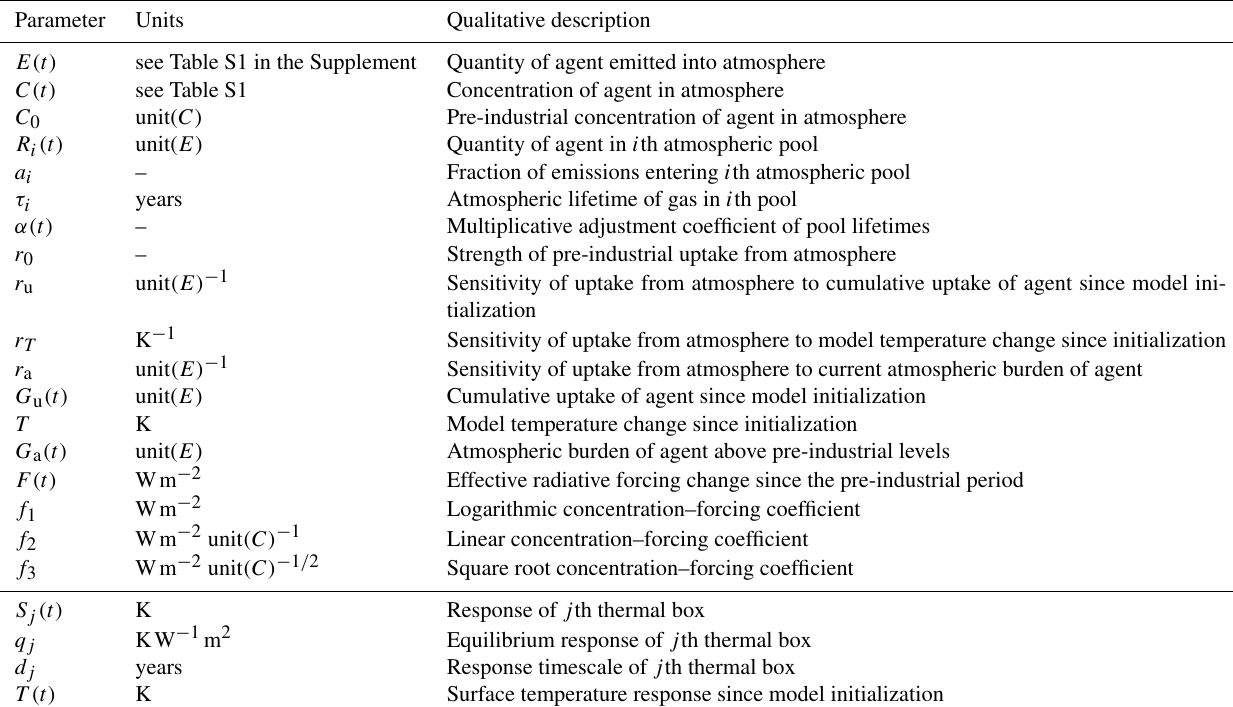
Table 1. Qualitative analogies for named parameters in FaIRv2.0.0. Parameter Units